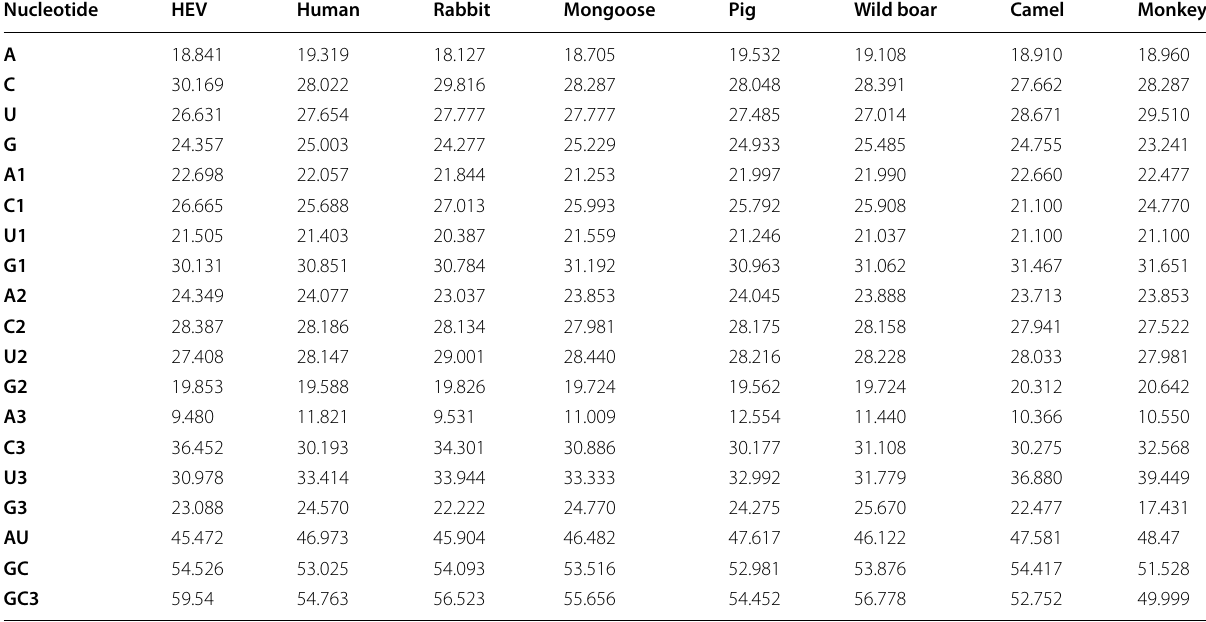
The values are represented as percentage